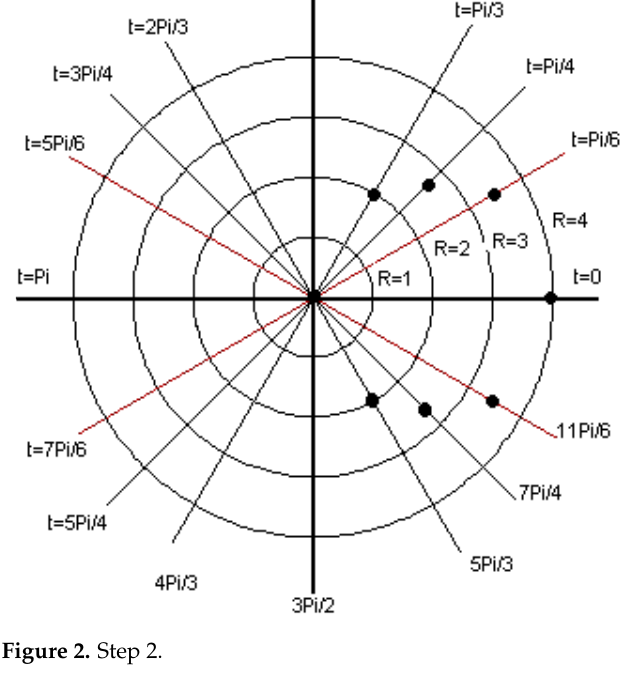
Figure 2. Step 2.